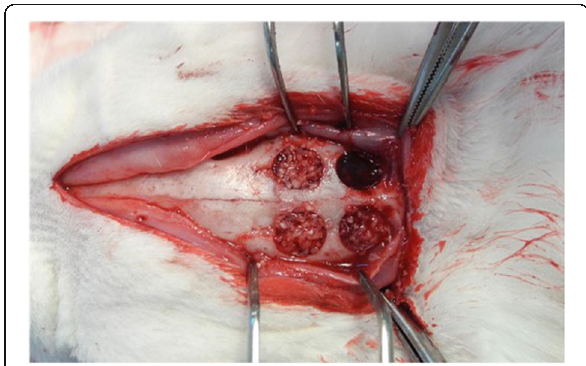
Fig. 2 A photo showing four same size defects (8 mm) at the dissected rabbit calvaria after the graft of AutoBT and type I